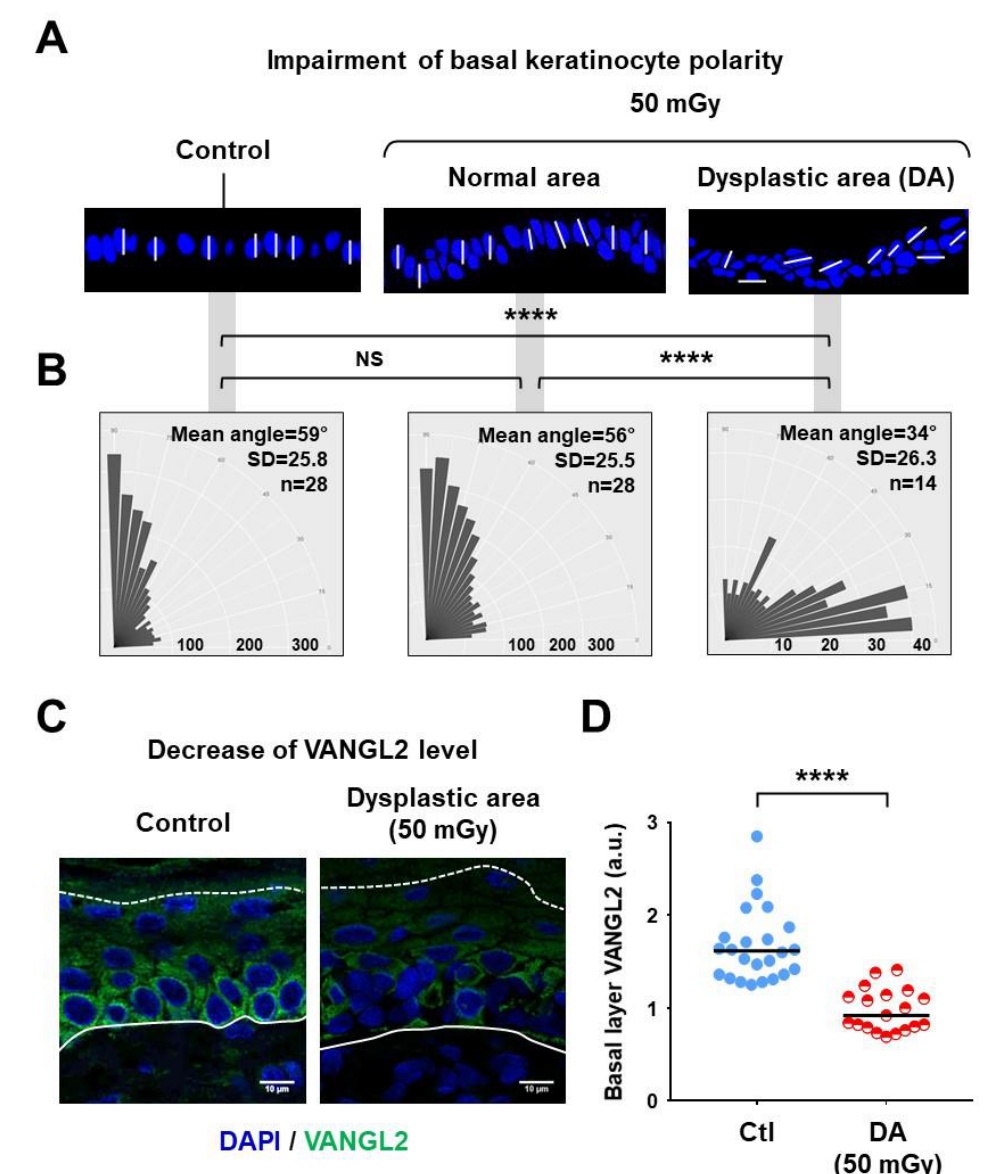
Figure 3. Perturbations of basal keratinocyte polarity in dysplastic epidermis areas of xenografts. ( A ) Imaging of basal keratinocyte nuclei orientation versus the dermo-epidermal junction (JDE) plane, after coloration with DAPI. Typical zoomed pictures of basal layer sections are shown, with white bars added to illustrate some perpendicular, oblique and parallel nuclei orientations. ( B ) Distribution of basal keratinocyte nuclei according to angle versus the JDE plan into 18 angle categories from 0° to 90°, characterized by automated image analysis. The vertical axis represents angle values and the horizontal axis numbers of cells in the different angle categories. Analysis was performed on 14 different xenografts for all conditions, n indicates numbers of analyzed dysplastic areas (NS p > 0.05; **** p < 0.0001, Mann–Whitney U test). ( C ) Immunofluorescence detection of VANGL2 protein. Representative pictures were selected for the visualization of VANGL2 in basal keratinocytes from normal epidermis regions, showing its decrease or absence in basal keratinocytes from dysplastic areas. Nuclei were colored with DAPI. ( D ) Quantification of VANGL2 fluorescence in the epidermis basal layer (arbitrary units, a.u.), showing a reduced signal within DAs. Dot plots cumulated the analyses of 24 normal regions from 14 control (Ctl) xenografts and 19 DAs from the 14 xenografts of the 50 mGy conditions. Bars correspond to median values. (**** p < 0.0001, Mann–Whitney U